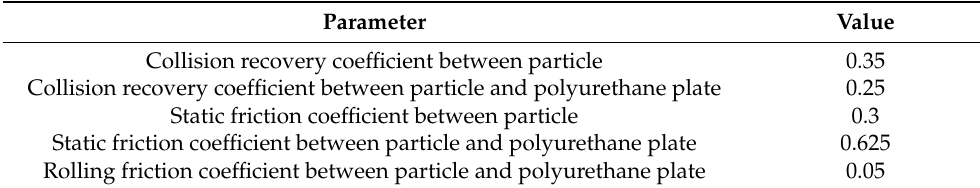
Table 2. Non-significant factors influencing the contact parameters of wet sand and